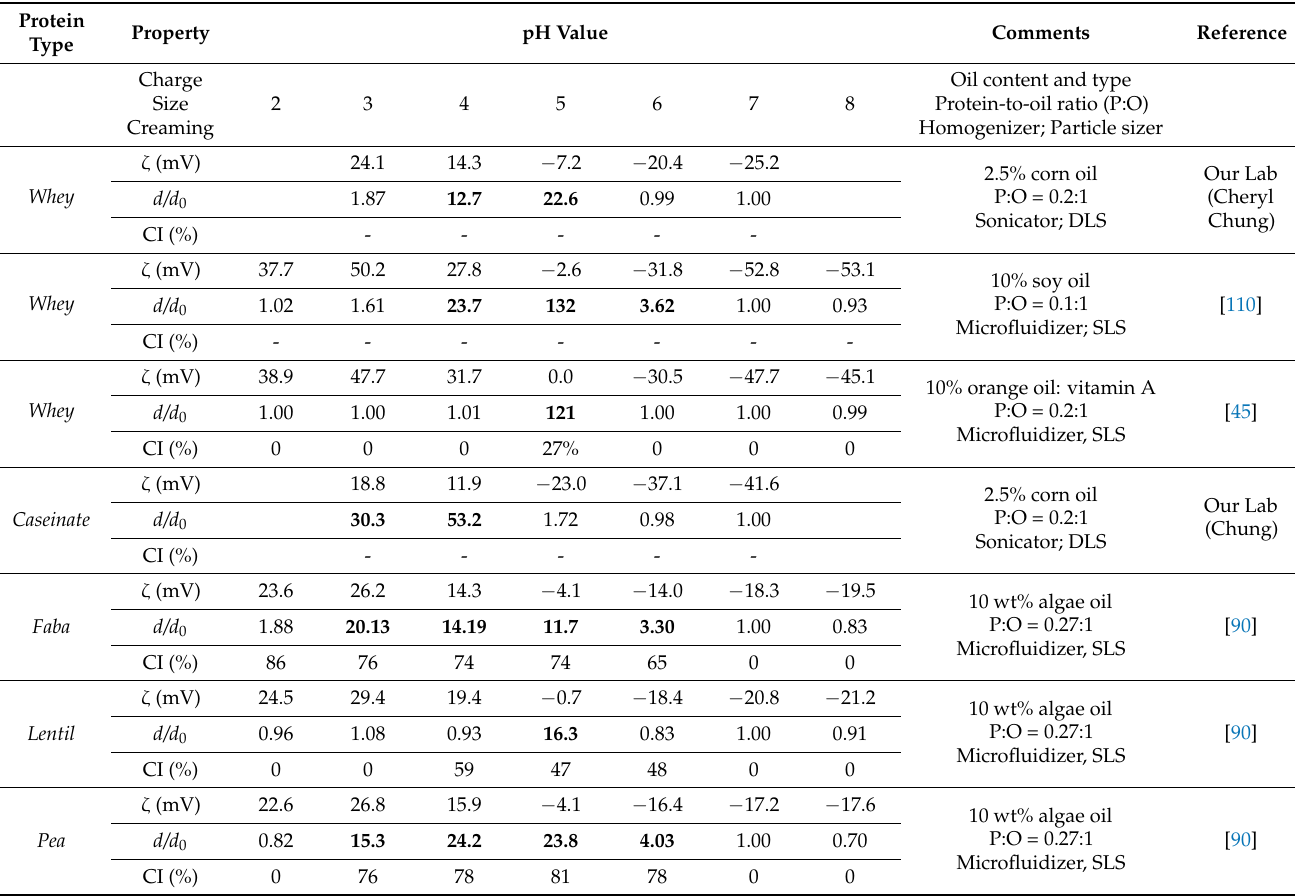
Table 2. pH stability of protein-coated oil droplets in oil-in-water emulsions. Regions in bold show where extensive droplet aggregation occurs. Key : ζ = ζ -potential; d/d 0 is the particle diameter at specified pH divided by particle diameter at pH 7; CI is the creaming index measured after storage for certain time at ambient